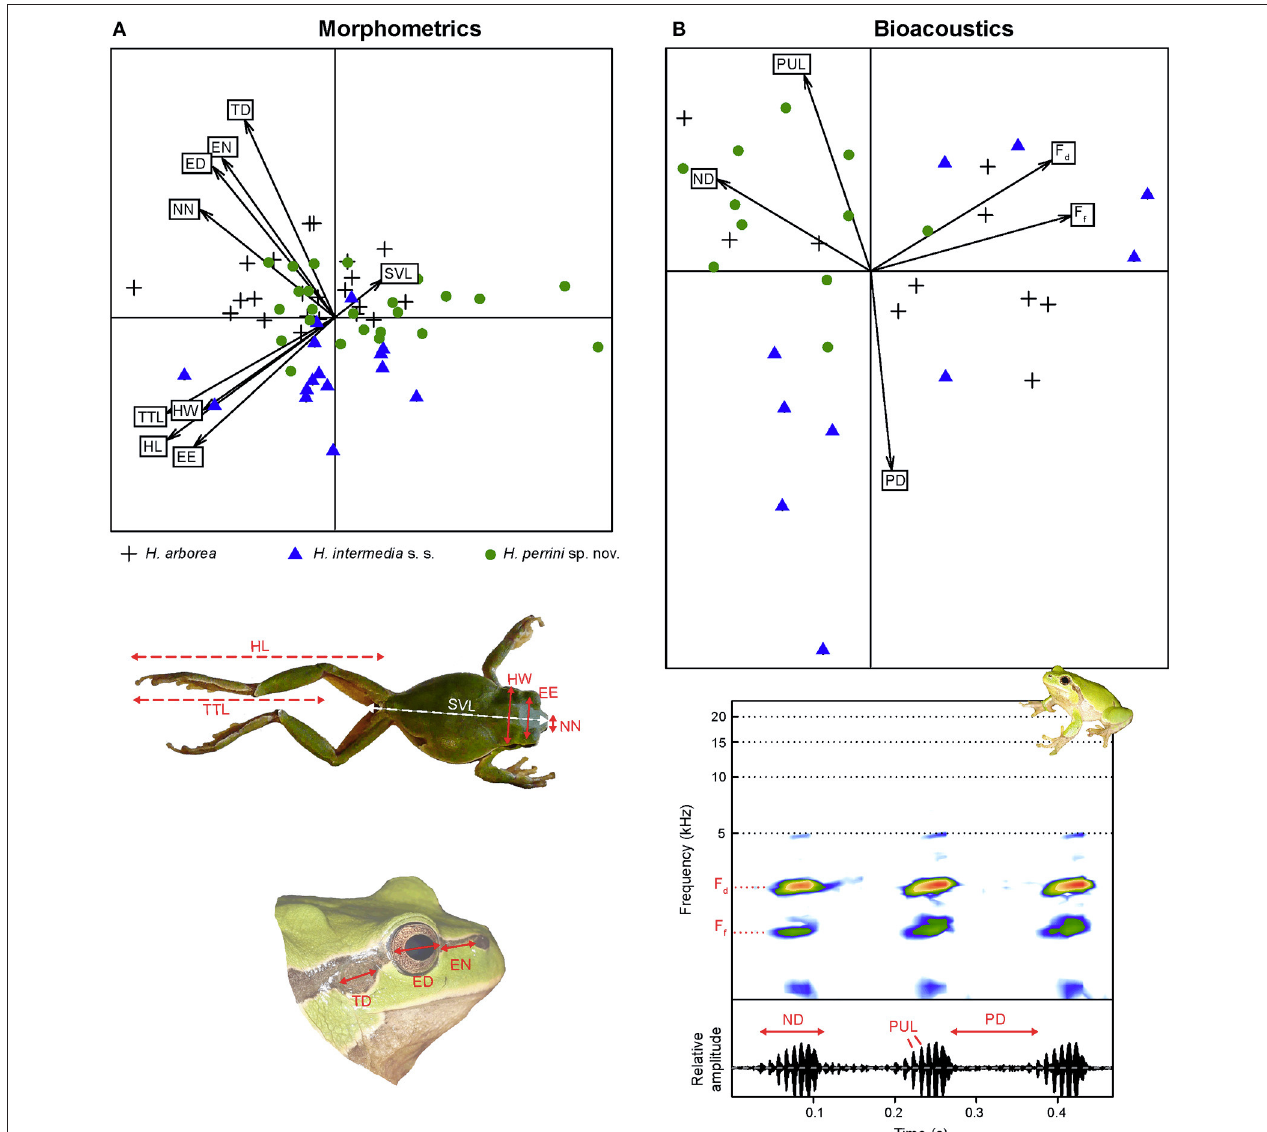
FIGURE 7 | Principal Component Analyses (PCA) on biometric variables of H. perrini sp. nov. (green circles), H. intermedia s. s. (blue triangles) and their close relative H. arborea (black crosses). (A) PCA on morphometric data. The photos illustrate the nine measurements included (see section Methods). (B) PCA on